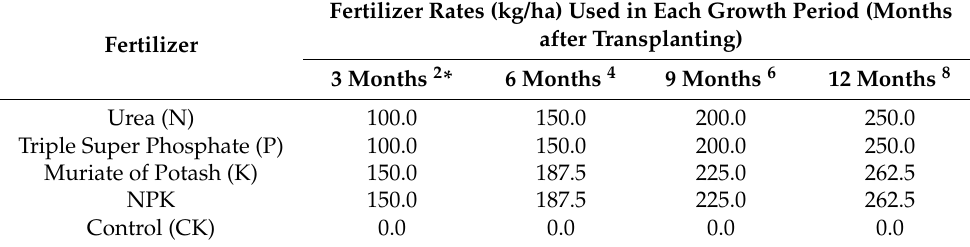
Table 9. Treatments and fertilizer rates used in the field and pot experiment.